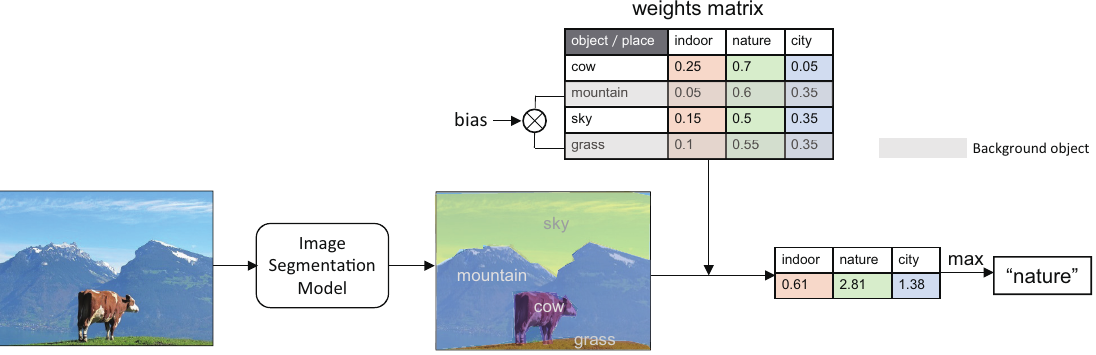
Figure 1. Overall structure of the proposed